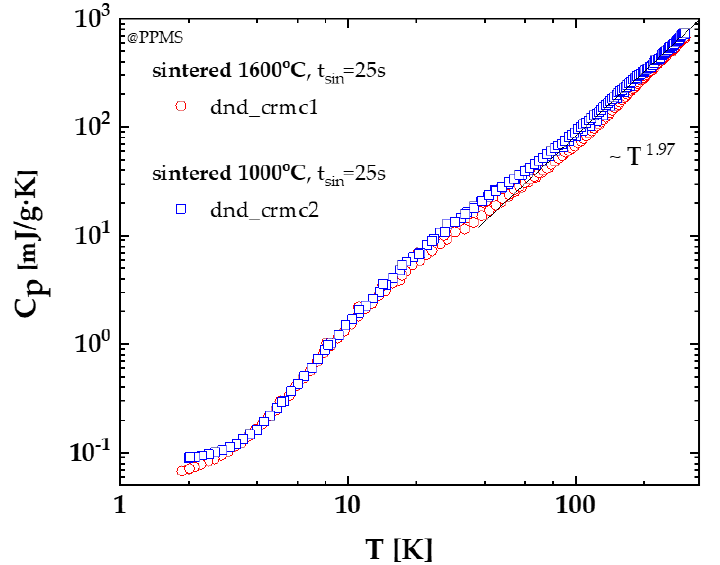
Figure 5. Specific heat as a function of temperature of detonated nanodiamond ceramics sintered at different temperatures measured with PPMS.